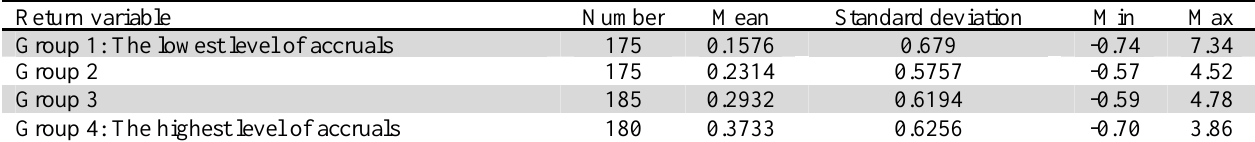
The summary of some basic statistics on different levels of accruals Return variable Number Mean Standard deviation Min Max Group 1: The lowest level of accruals 175 Group 2 Group 4: The highest level of